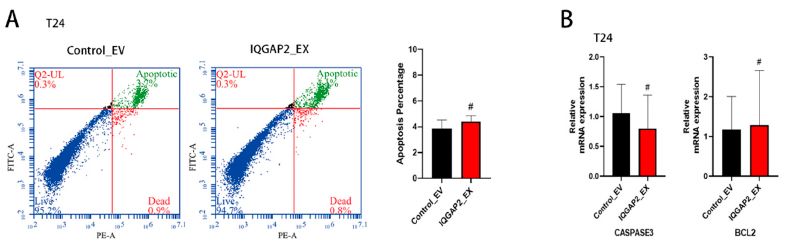
Figure 3. IQGAP2 did not influence cell apoptosis in bladder cancer cells. ( A ) Cell apoptosis was measured using flow cytometry in IQGAP-overexpressing (IQGAP_EX) T24 and control cells (empty vector—EV). ( B ) Cell apoptosis markers Caspase 3 and BCL2 showed no different mRNA expression in T24 IQGAP2_EX and Control_EV. One example of replicates is shown; bar chart presents the means of replicates ± SEM from three different experiments; # indicates p > 0.05; Student’s t -test (two-tailed, unpaired) was used for comparison of means.